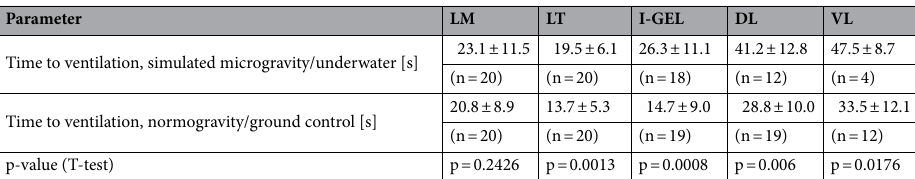
Table 2. Time to ventilation in different groups. Statistically significant values (t-test) are printed in bold